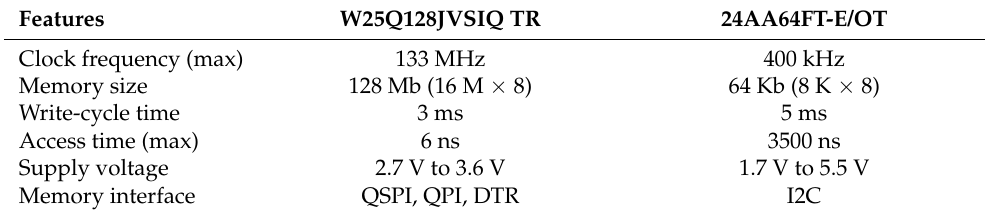
Table 4. W25Q128JVSIQ TR (https://www.winbond.com/resource-files/w25q128jv%20revf%200327 2018%20plus.pdf, accessed on 27 March 2023) and 24AA64FT-E/OT